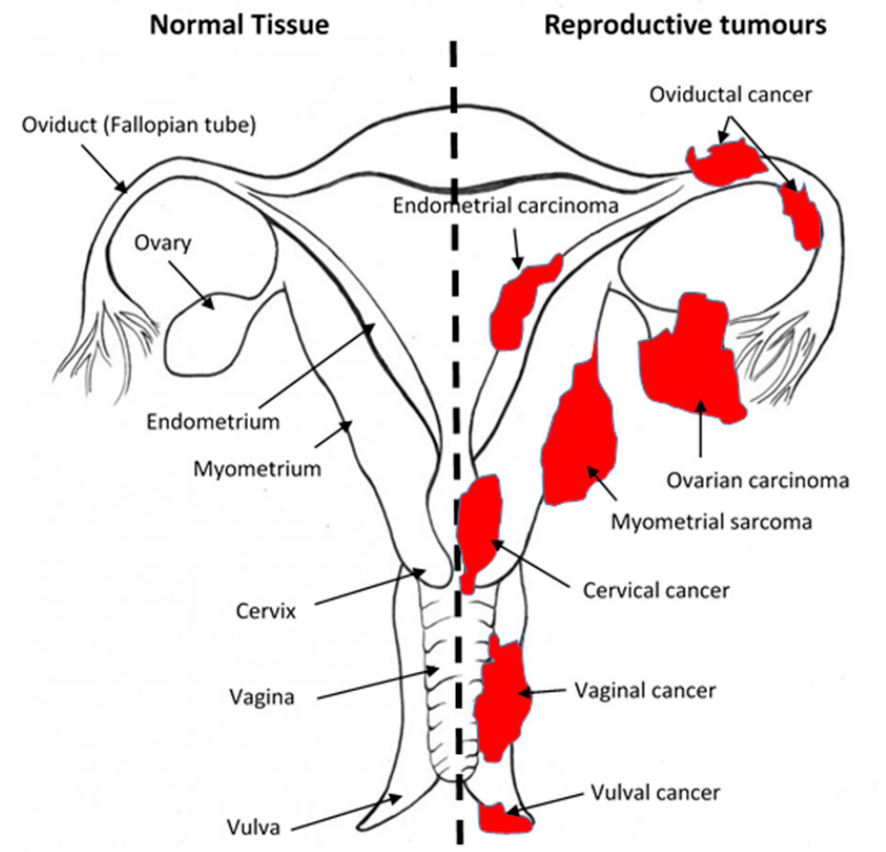
Figure 2. Sites of gynaecological cancers in the female reproductive tract. The diagram indicates the names of the normal tissues of the female reproductive tract (left side) and the sites and names of the cancers (right side) for the corresponding normal tissues. Please add copyright if necessary.